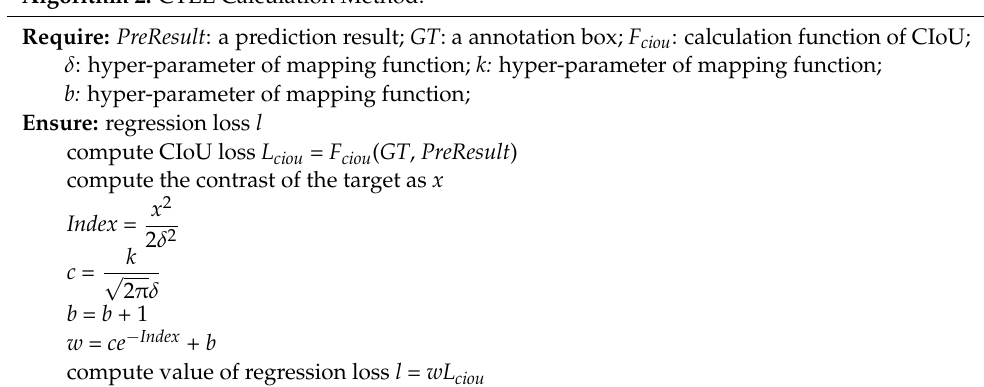
Algorithm 2. CTEL Calculation